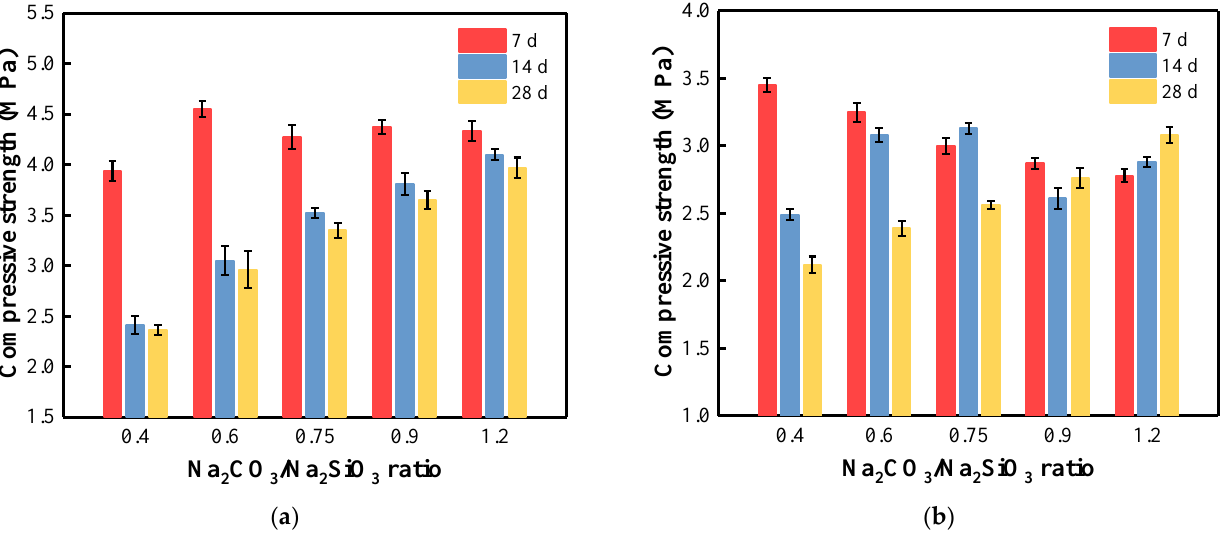
Figure 13. Compressive strength of AAM pastes with different C/S ratios cured at ( a ) 40 °C and ( b ) 20 °C. ( b ) 20 ◦